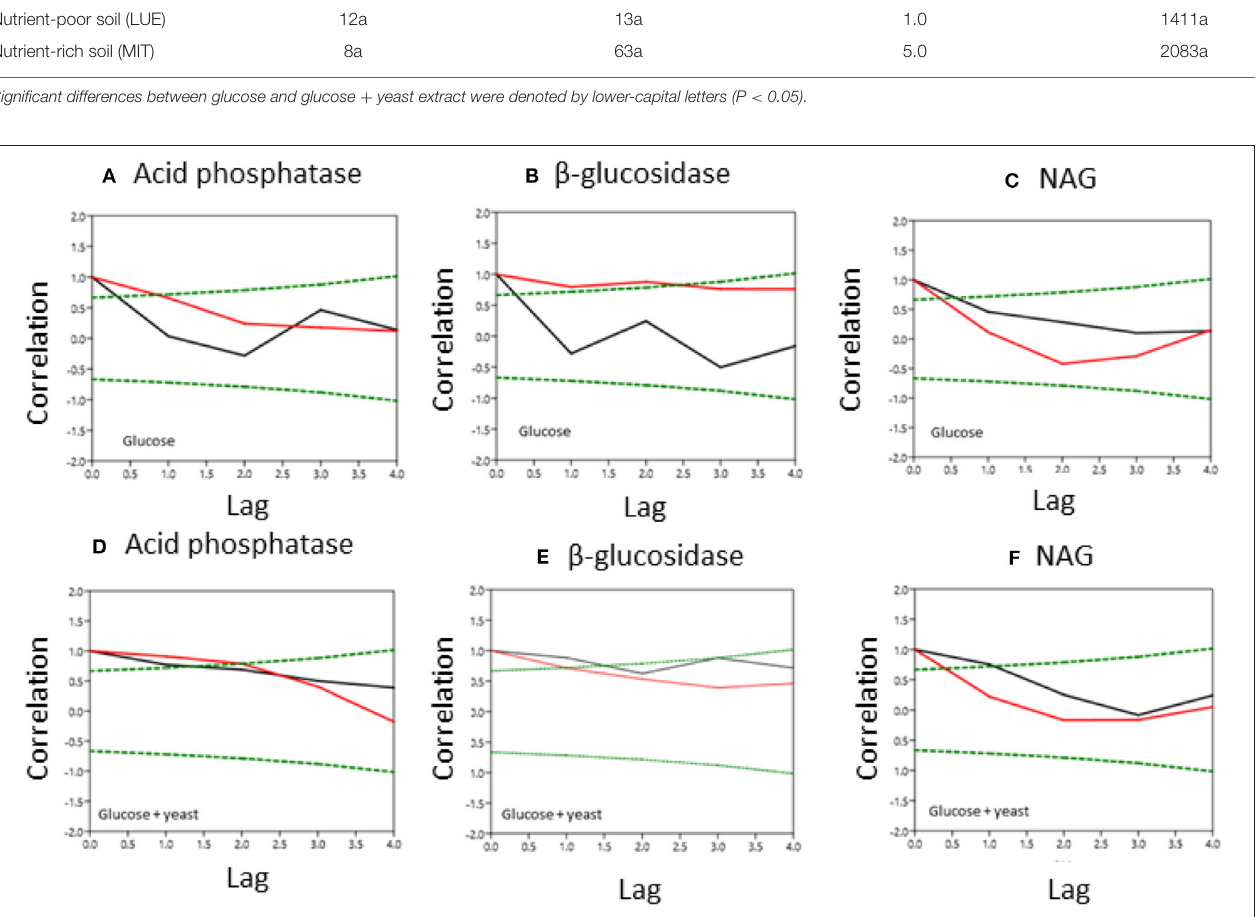
FIGURE 6 | Normalized covariance function of enzyme activities during microbial growth in nutrient-poor (black line) and nutrient-rich (red line) soils. Upper graphs show glucose amendment and below graphs depict glucose + yeast extract. The x-axis shows the lag in hours and y-axis the correlation coefficient. The green dashed line denotes the confidence bands ( P < 0.05), reflecting the significant confidence interval of autocorrelation. (A, D) acid phosphatase, (B,E) beta-glucosidase; (C,F)